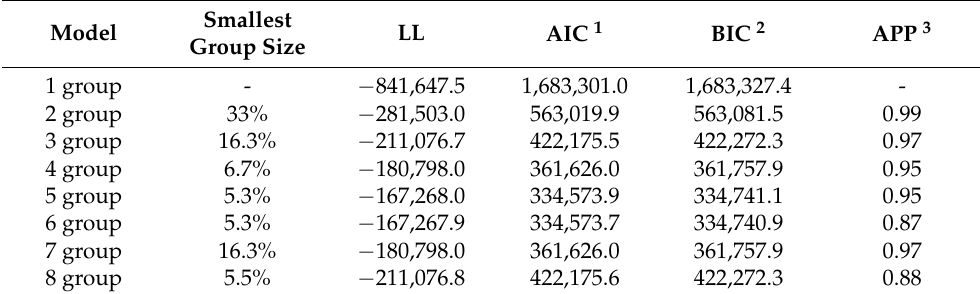
Table 1. The goodness of fit of group-based trajectory analysis for sample 1.